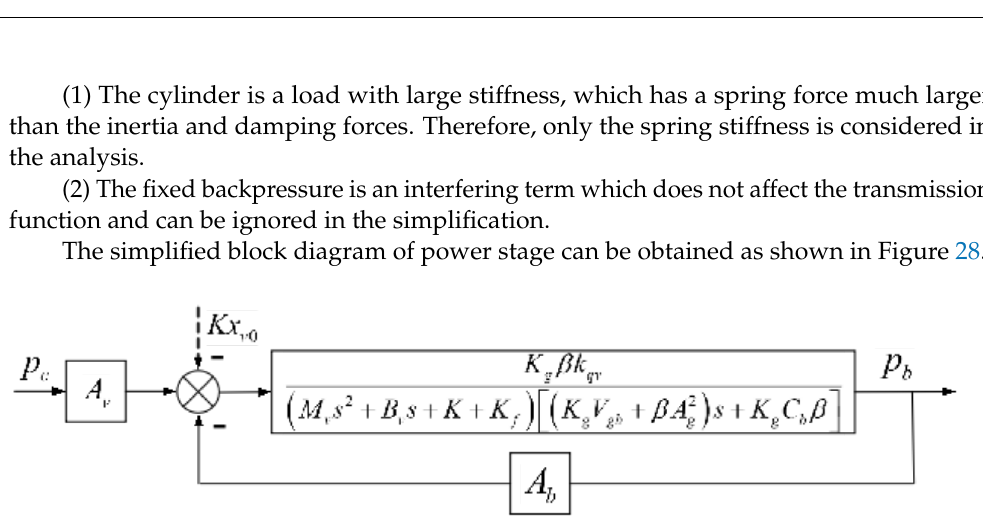
Figure 28. Simplified control block diagram of power stage.